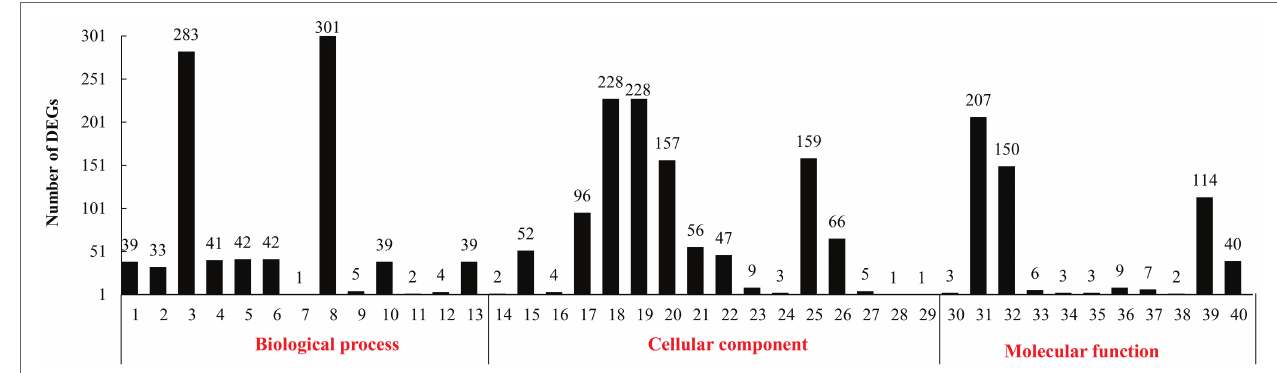
FIGURE 1 | Gene ontology (GO) functional classification of differentially expressed genes (DEGs). (1): biological regulation. (2): cellular component organization or biogenesis. (3): cellular process. (4): developmental process. (5): establishment of localization. (6): localization. (7): locomotion. (8): metabolic process. (9): multi- organism process. (10): multicellular organismal process. (11): negative regulation of biological process. (12): positive regulation of biological process. (13): regulation of biological process. (14): reproduction. (15): response to stimulus. (16): signaling. (17): single-organism process. (18): cell. (19): cell part. (20): macromolecular complex. (21): membrane. (22): membrane part. (23): membrane-enclosed lumen. (24): nucleoid. (25): organelle. (26): organelle part. (27): synapse. (28): virion. (29): virion part. (30): antioxidant activity. (31): binding. (32): catalytic activity. (33): electron carrier activity. (34): enzyme regulator activity. (35): molecular transducer activity. (36): nucleic acid binding transcription factor activity. (37): protein binding transcription factor activity. (38): receptor activity. (39): structural molecule activity. (40): transporter